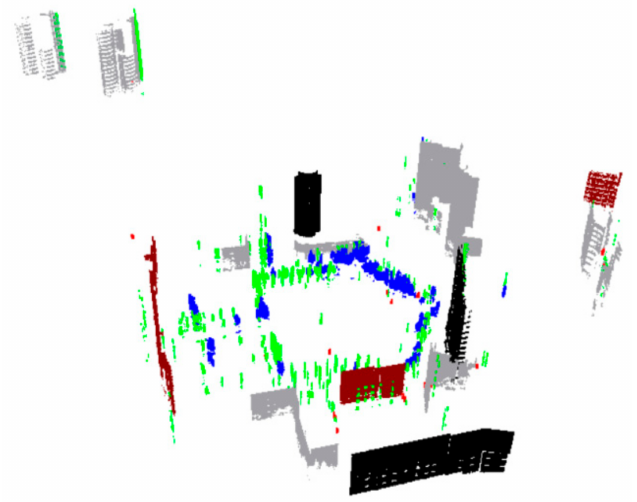
Figure 13. Results of different steps in the decision tree, including two classes: (1) points filtered by height difference (red), compactness (green) and planar ratio (blue); (2) points preserved by horizontal hollow ratio (gray), model-based planar ratio (maroon) and point-based planar ratio